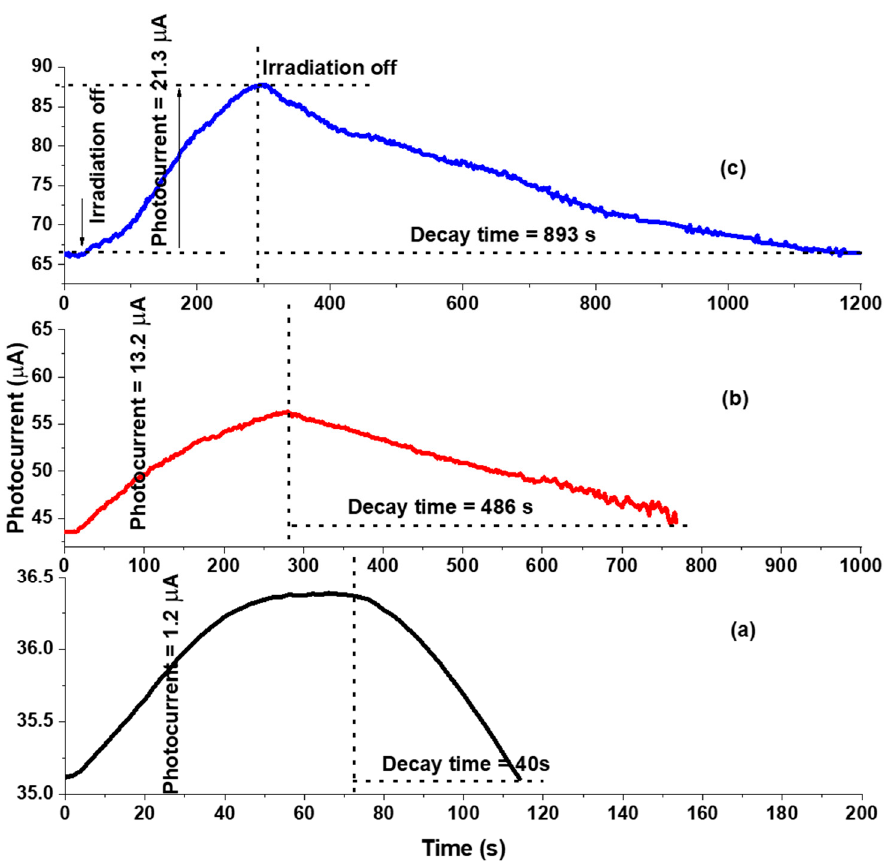
Figure 10. The photocurrent signals of ( a ) TiO 2 , ( b ) TiO 2 /1 mg-KBrO 3 , and ( c ) TiO 2 /5 mg-KBrO 3 sam- ples were measured at a voltage bias of 0.2 V. samples were measured at a voltage bias of 0.2